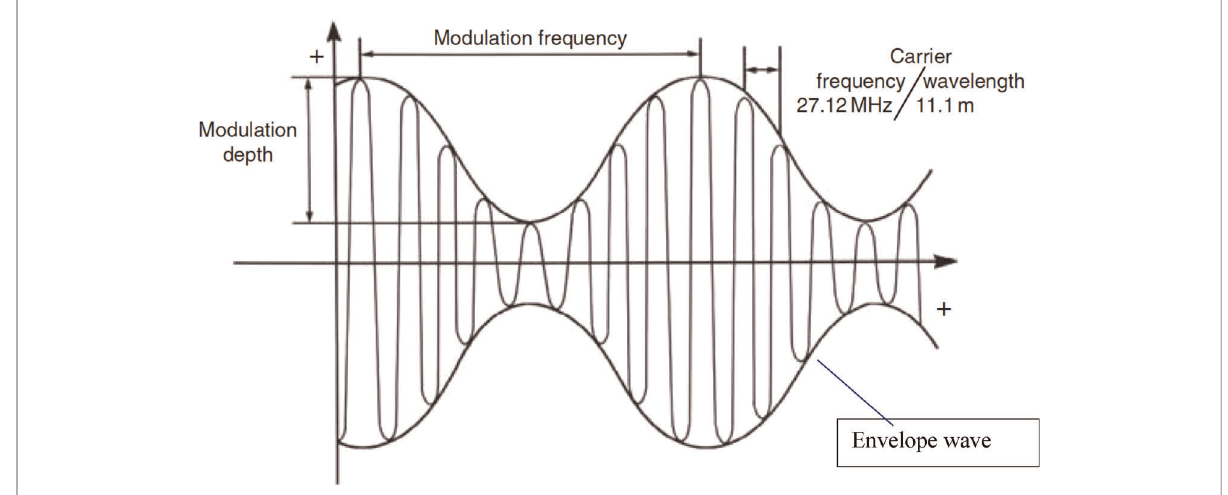
FIGURE 1 Schematic description of an amplitude-modulated radiofrequency electromagnetic wave. The carrier frequency (27.12 MHz) is sinusoidally modulated at speci fi c frequencies